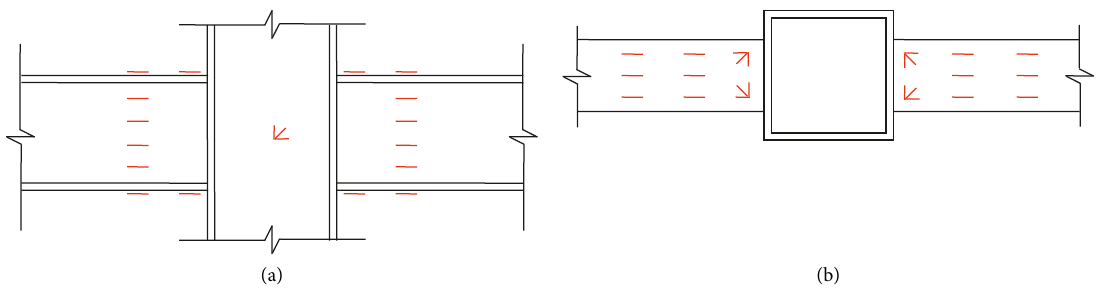
Figure 4: Strain gauge arrangement. (a) Front view and (b) top view.